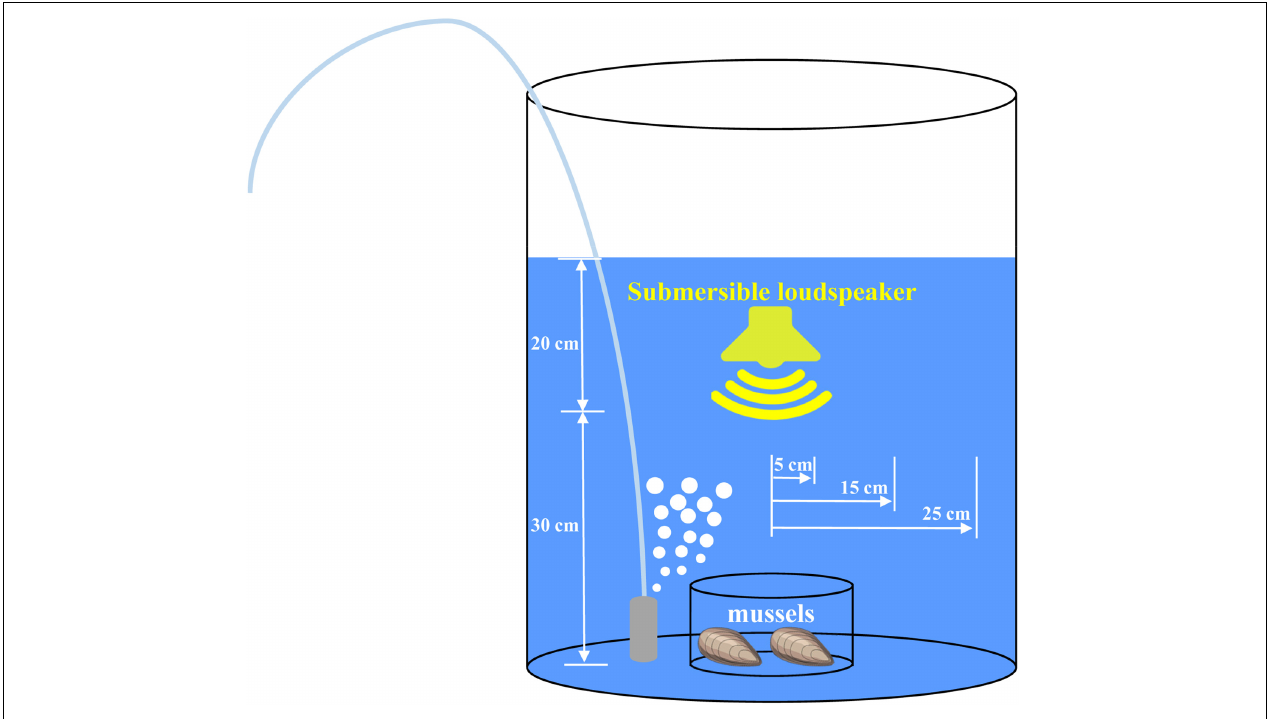
FIGURE 1 | Schematic diagram of the experimental setup and the positions where underwater acoustic conditions were determined.